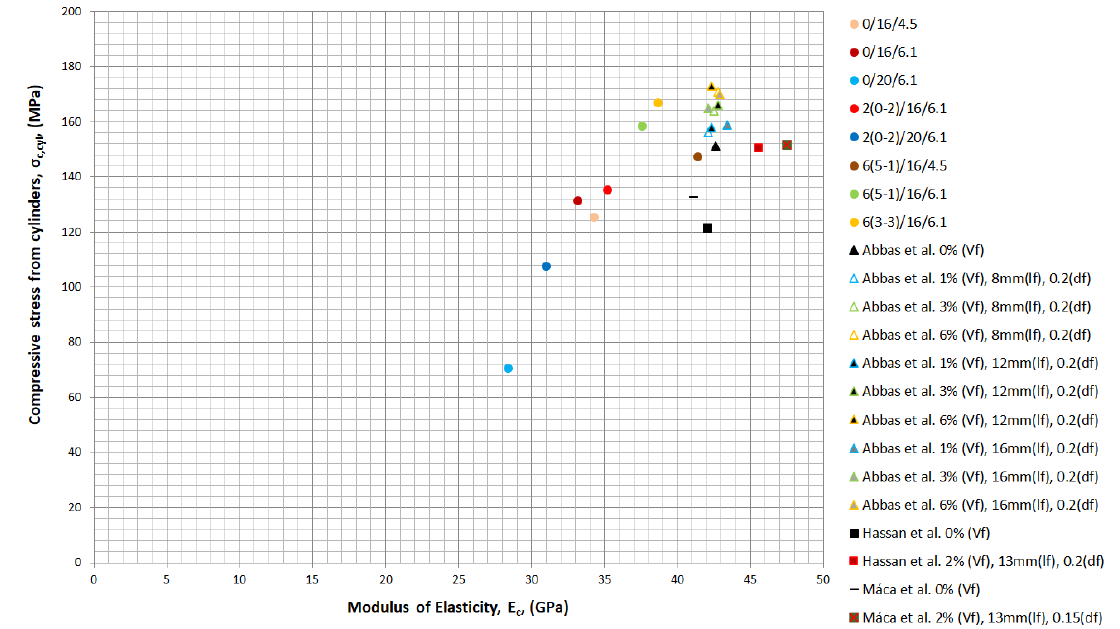
Figure 6. Comparison with literature of compressive stress from cylinders ( σ c,cyl ) and modulus of elasticity (E c ).